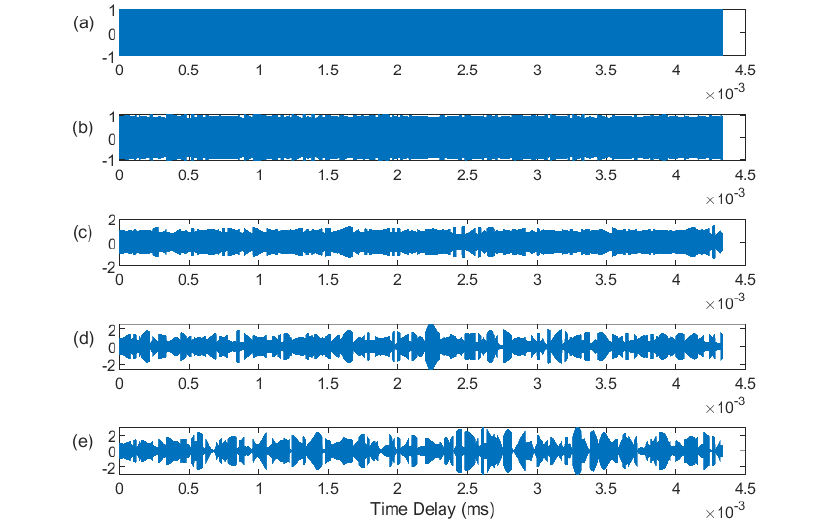
Figure 3. The echo signals of conventional method under different inband SNR: ( a ) Pure echo signal; ( b ) echo signal at SNR = 25 dB; ( c ) echo signal at SNR = 15 dB; ( d ) echo signal at SNR = 5 dB; and ( e ) echo signal at SNR = 0 dB.